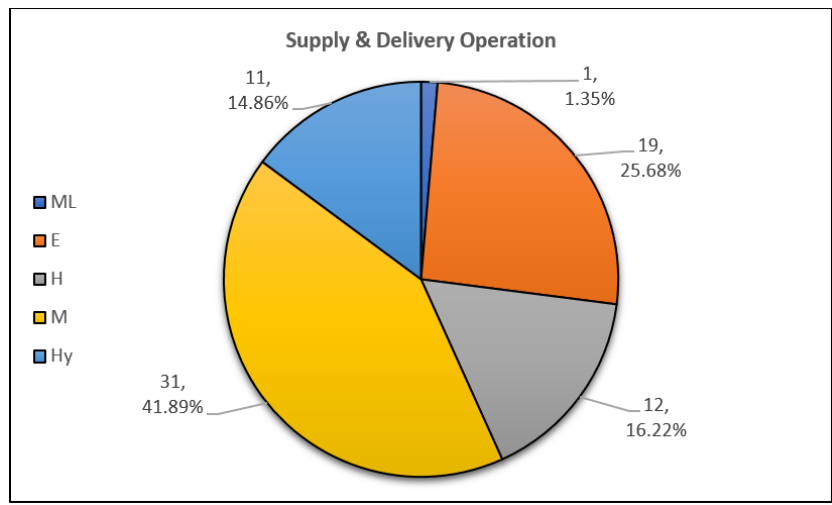
Figure 31. Breakdown of VRP for Supply & Delivery Operation based on Solution Approach.